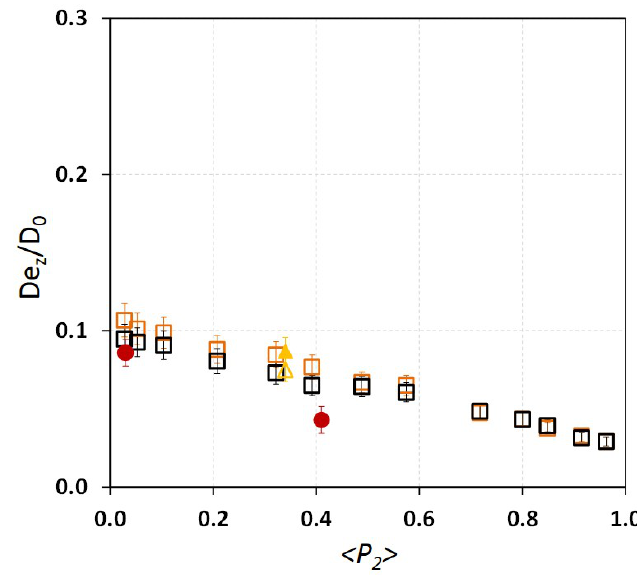
Figure 23. Influence of the particle orientation and interlayer porosity on the apparent mobility of water molecules (i.e., effective diffusion coefficient) diffusing through clay porous media in the direction perpendicular to the preferred orientation of the clay particles. Data are normalized to the self-diffusion coefficient of water in bulk solution. The data obtained for kaolinite (single porosity of ∼ 0.26) by 1 H NMR PGSE attenuation (empty yellow triangle) and TD experiments (full yellow triangle) are taken from Asaad et al. [55] and Tertre et al. [94], respectively. TD data obtained for vermiculite (dual porosity) for a similar interparticle porosity are shown as full red circles [55]. Experimental data are compared with results from BD simulations (empty squares) taking into account interlayer diffusion (orange symbols) or only the mobility in the interparticle volume (black symbols) [55]. Reprinted from Ref. [55]. Copyright (2021), with permission from